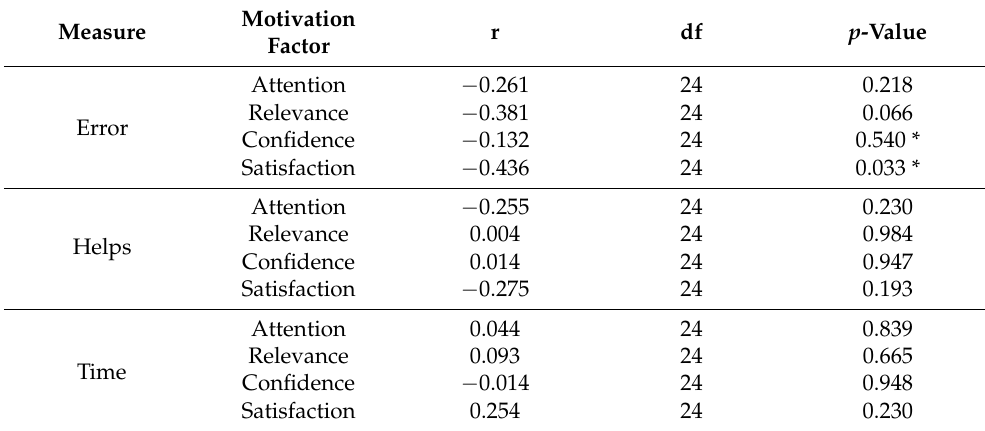
Table 5. Correlation results between motivational factors and students’ interaction with the AR-based learning environment in the control group.